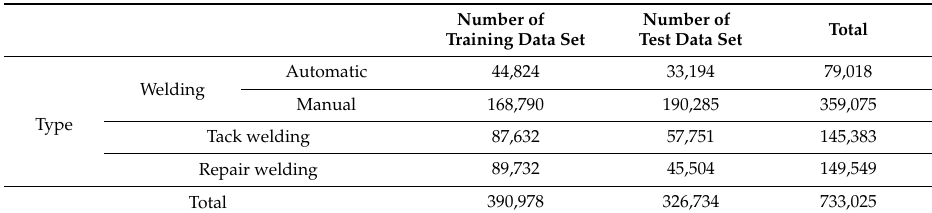
Table 3. Numbers of training and test data set.